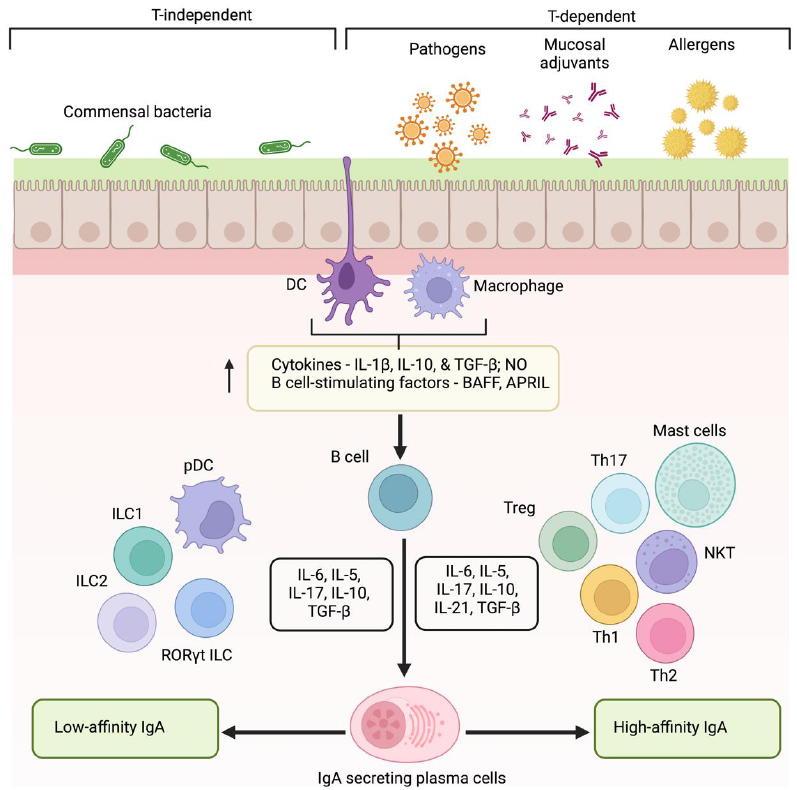
Figure 2. Mechanism of low- and high-affinity IgA production. Induction of IgA occurs in a T-dependent and independent manner. Mucosal surface exposure to allergens, pathogens, or vaccines triggers epithelial cells and antigen-presenting cells (DCs and macrophages) to elicit the production of cytokines, NO, and BAFF, and APRIL to activate B lymphocytes. Class switching to high-affinity IgA occurs with the aid of Th cells through a T cell-dependent manner. On the contrary, plasmacytoid DCs and ILCs favor the induction of low-affinity IgA. (DCs—dendritic cells, NO—nitric oxide, BAFF—B cell activating factor, APRIL—a proliferation-inducing ligand, ILCs—innate lymphoid